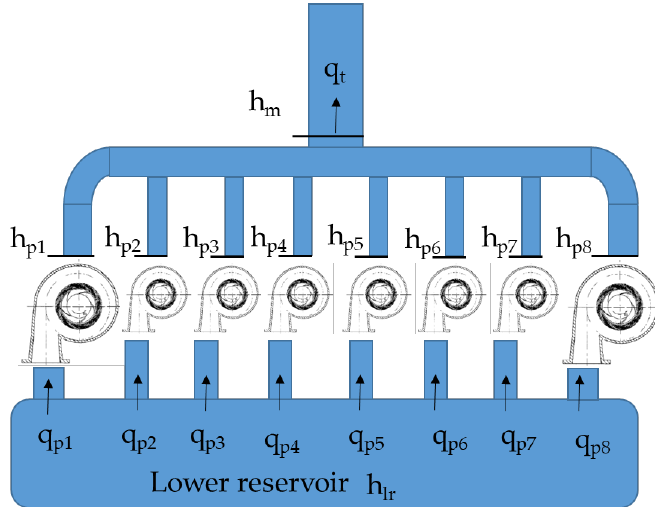
Figure 4. Pump station hydraulic scheme.